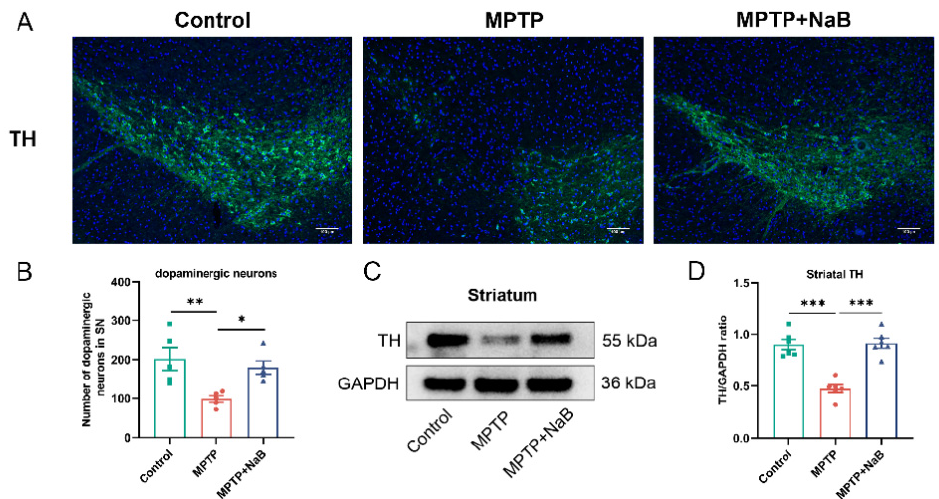
Figure 3. Sodium butyrate (NaB) enhances the number of dopaminergic neurons and tyrosine hydroxylase (TH) expression in Parkinson’s disease (PD) mice. ( A ) Images showing immunofluorescence staining in the substantia nigra for markers TH (green) of dopaminergic neurons and nuclei DAPI (blue). The scale bar measures 100 µ m. ( B ) Quantification of TH+ dopaminergic neurons in the substantia nigra using ImageJ. ( C ) Representative Western blot that indicated TH expression in the striatum. ( D ) The intensities of the TH bands were quantified using ImageJ and normalized to GAPDH. n = 5 mice for each group; * p < 0.05, ** p < 0.01, *** p < 0.001; data are expressed as means ± SEM.